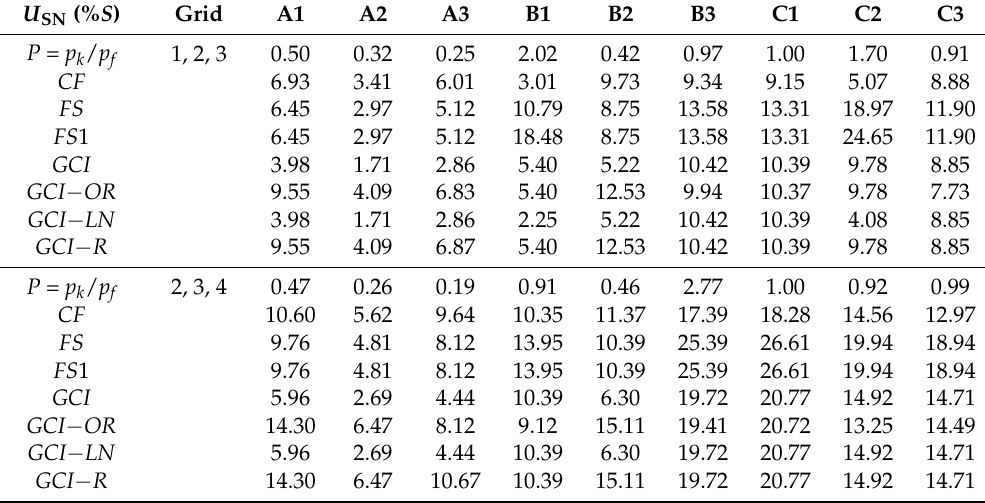
Table 4. Uncertainty estimation of seven estimators for stream-wise